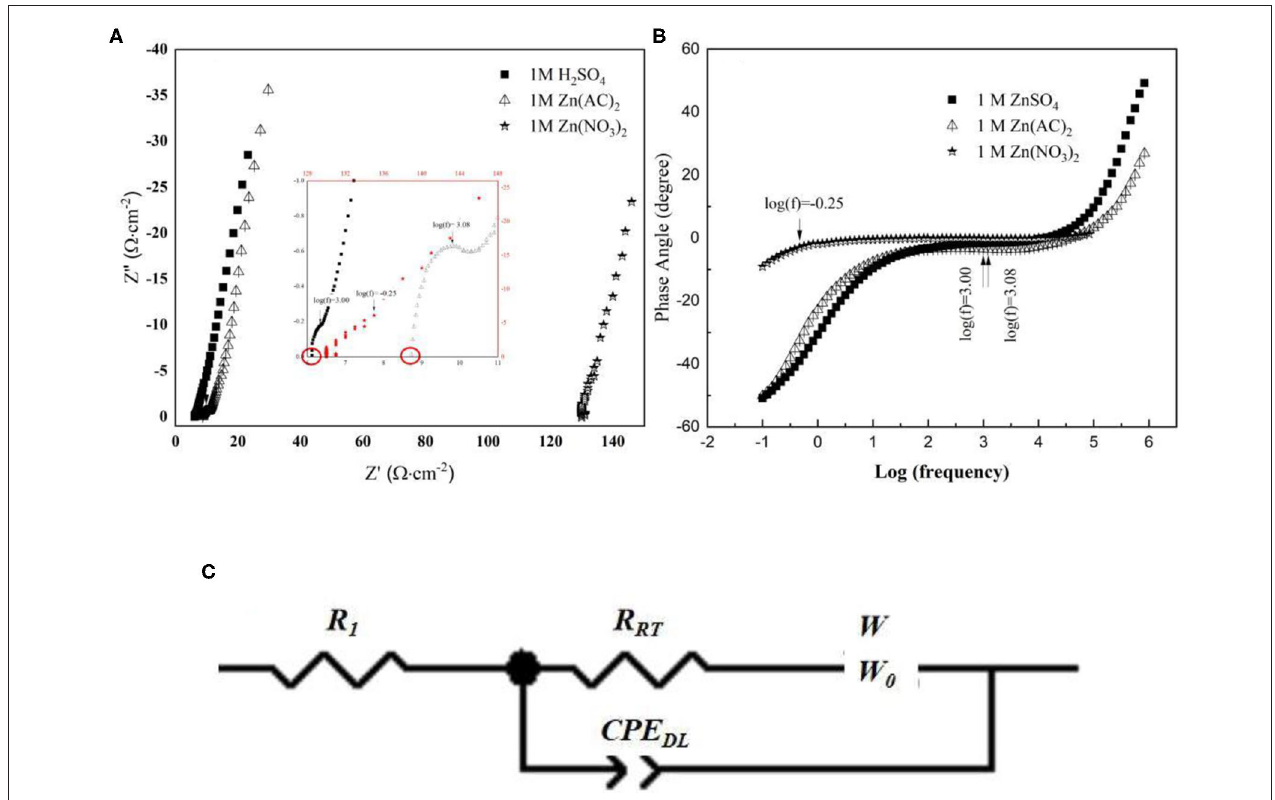
FIGURE 2 | (A) EIS Nyquist plots and Bode plots (B) collected from a three-electrode system with different electrolyte; (C) Equivalent Circuit for data fitting.